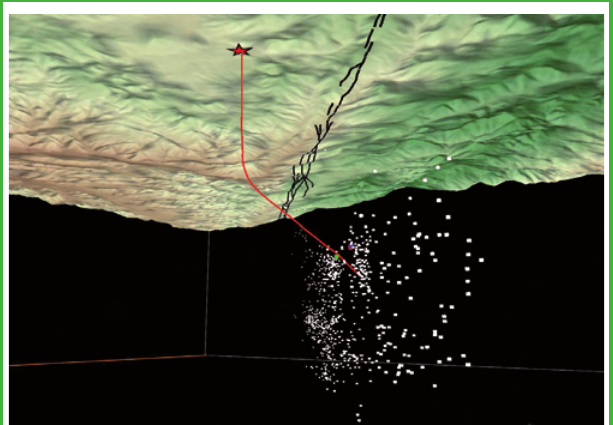
Figure 1. Seismicity of the San Andreas fault as seen from a vantage point in the earth looking to the northwest. Hypocenters were determined using tomoDD by Haijiang Zhang (University of Wisconsin - Madison) utilizing data from the Parkfield Area Seismic Observatory, supplemented by data from local USGS and University of California - Berkeley network stations. The San Andreas fault is made visible by more than 1000 microearthquakes. The SAFOD main hole is shown in red, extending downward from the surface facility (star). The surface trace of the fault is shown in black draped over the topography (3-D EarthVision plot by Luke Blair,